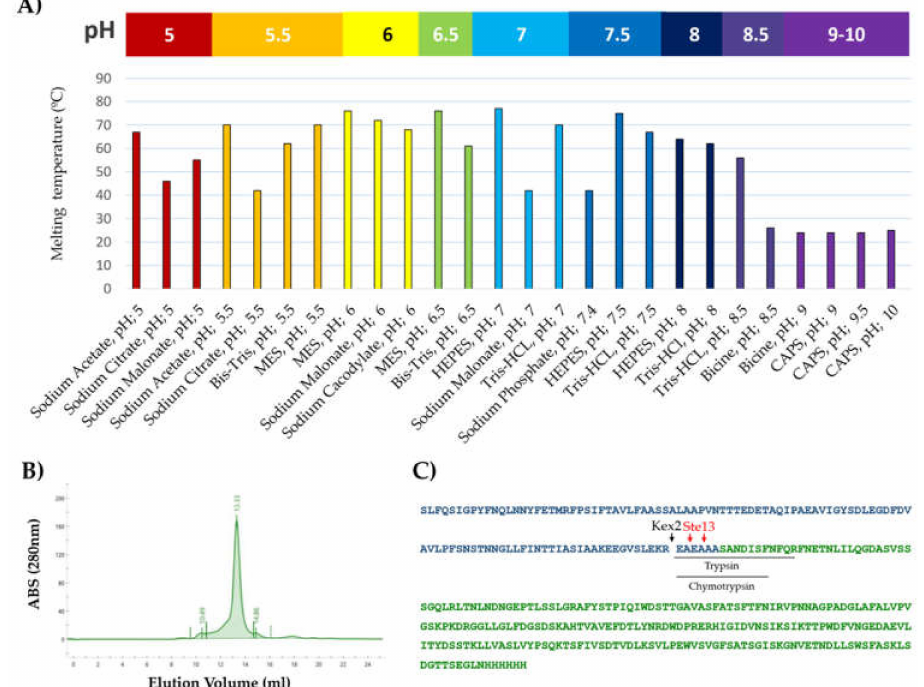
Figure 2. Characterization of r TBL-1: ( A ) Melting temperatures of r TBL-1 obtained through thermal shift assay (TSA). A temperature gradient from 20 to 100 ◦ C was applied under 26 di ff erent bu ff er conditions in a pH range from 5 to 10. ( B ) Size exclusion chromatogram of rTBL-1: The column was calibrated using the gel filtration standard #15119001 (Bio-Rad). ( C ) Sequence of r TBL-1 by mass spectrometry; green depicts r TBL-1 sequence; blue represents α -factor sequence; black lines indicate the most abundant tryptic and chemotryptic N-terminal peptides found in the digested samples; and cleavage sites for Kex2 and Ste13 are indicated by black and red arrows,